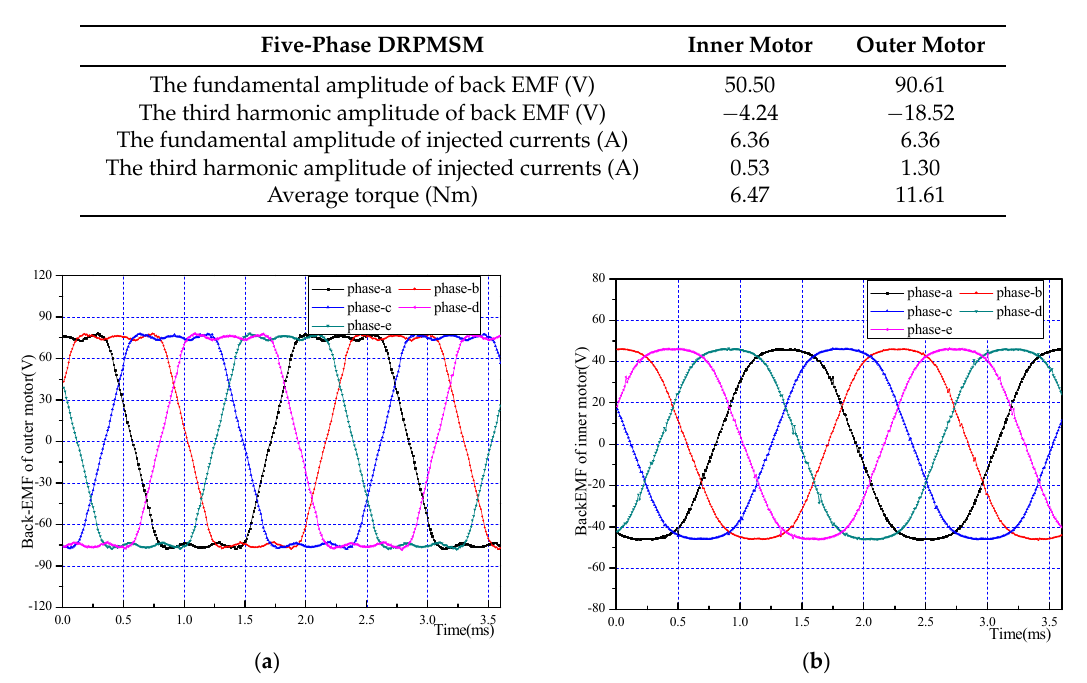
Figure 9. The parallel drive model of the five ‐ phase DRPMSM.